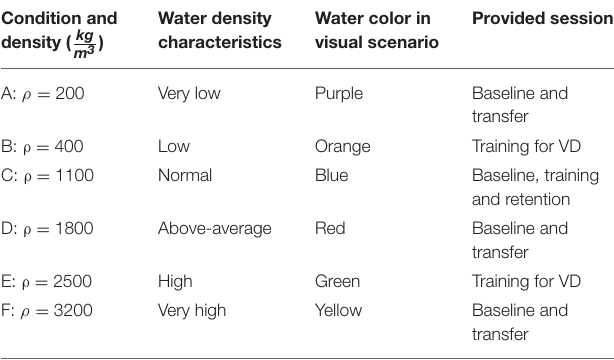
TABLE 1 | Selected density values for haptic rendering of different virtual water conditions: Water density characteristics column lists the magnitude of perceived water resistance